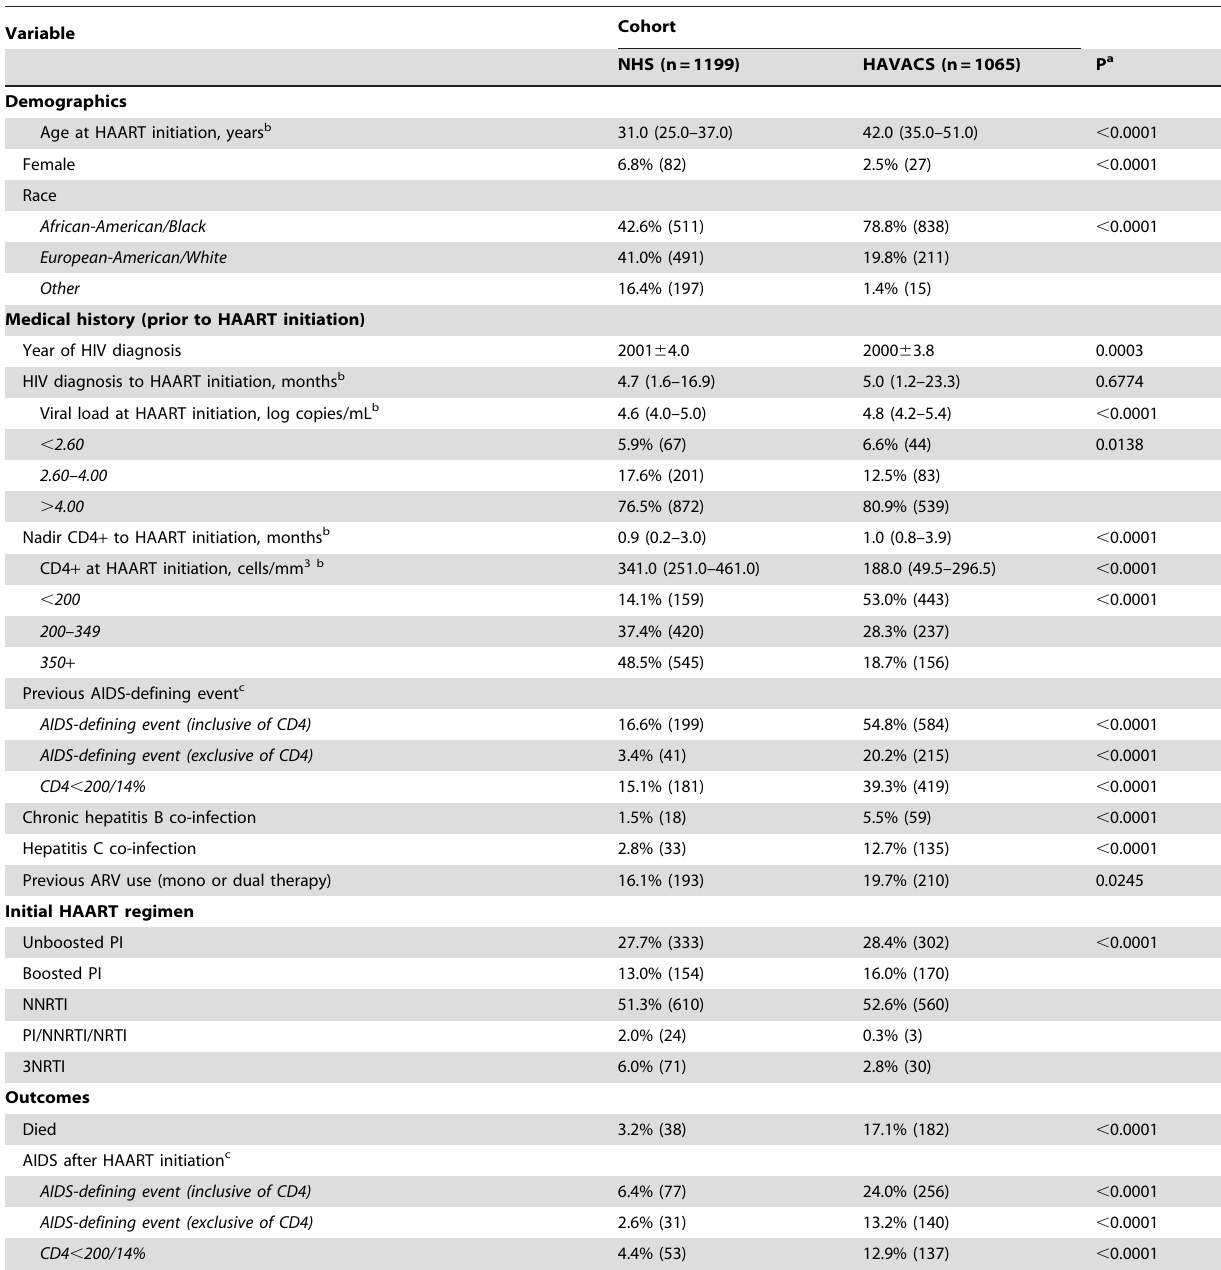
Table 1. Distributions of variables between NHS and